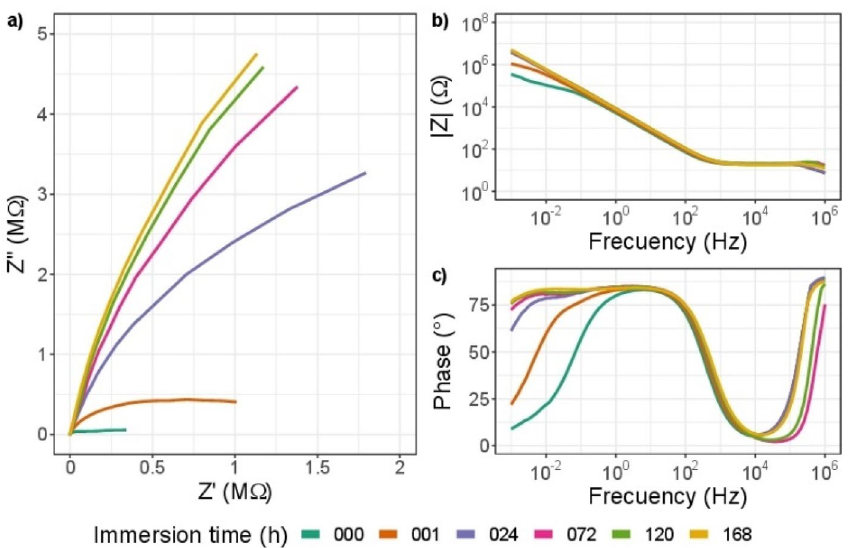
Figure 13. EIS diagram for impedance modulus obtained after different immersion times in 3.5% wt NaCl solution for stainless steel 316L ( a ) Nyquist impedance ( b ) Bode impedance and ( c ) Bode phase angle